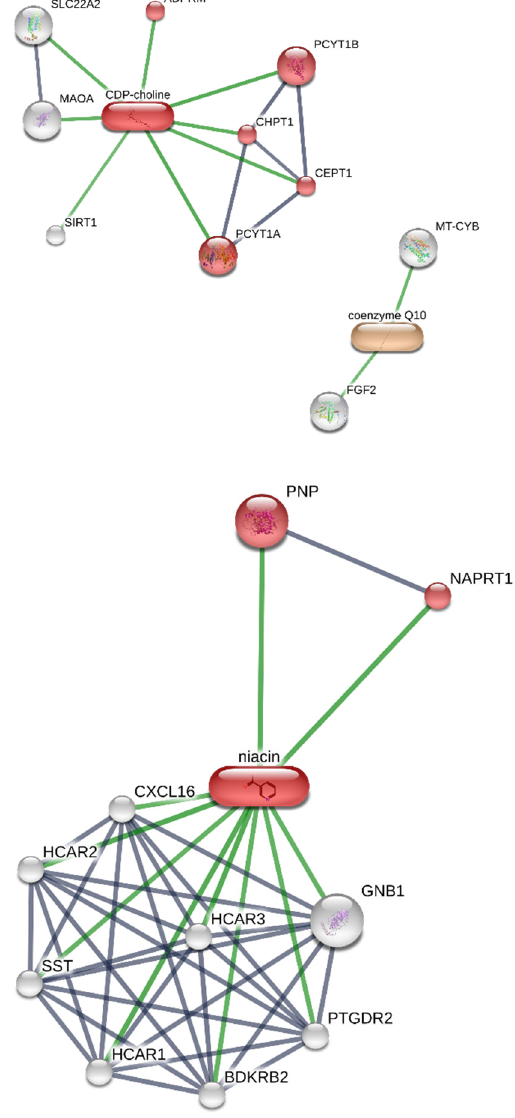
Figure 3. Results of the components-targets analysis conducted via the platform STITCH. The results suggested the capability of citicoline to interact with monoamine oxidase A (MAO-A). Additionally, citicoline was predicted to modulate dopamine uptake, through interaction with the neurotransmitter carrier (SLC22A2), and through phosphatidylcholine synthesis, in which it interacts with phosphate cytidylyltransferases (PCYT1B and PCYT1A). On the other hand, CAVAQ10 was predicted to interact with cytochrome b (MT-CYB), involved in the ATP biosynthesis, and fibroblast growth factor-2 (FGF2).